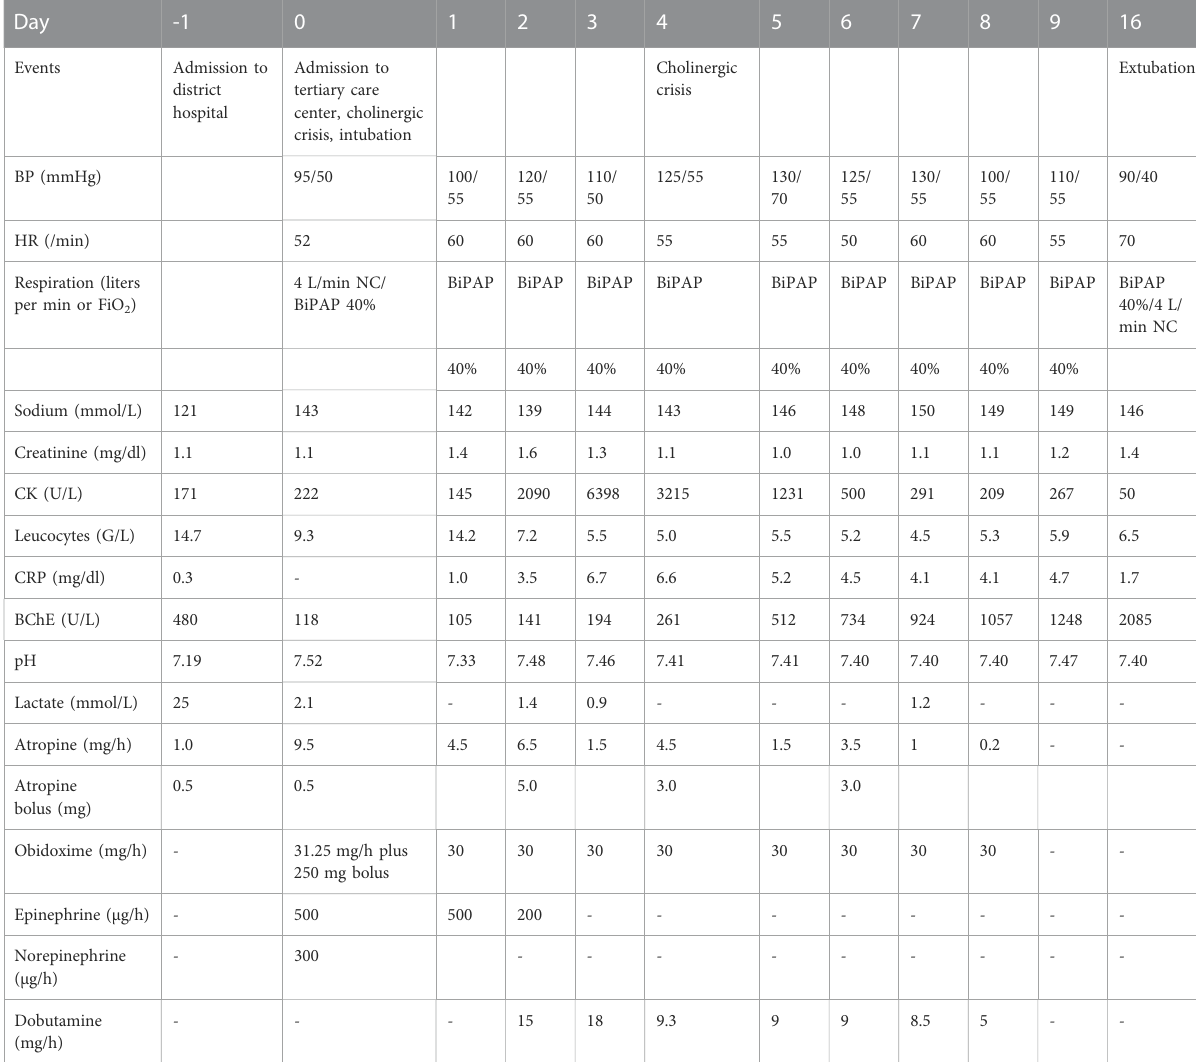
TABLE 1 Clinical course of patient from admission to primary care center until extubation, showing the clinical course of the intoxication. Blood pressure and heartrate aregiven as the lowest daily value, medicationsas theirhighestinfusionrate onthe respective day,O 2 isdisplayed in litersper minute, andFiO 2 in percent (also highest daily fl ow rates/percentages). Laboratory results from the respective clinical laboratories. Cumulative atropine = 248 mg (12 mg as bolus, 236 mg as continuous infusion), BP = blood pressure, HR = heart rate, CRP = C-reactive protein, CK = creatinine kinase, BChE =